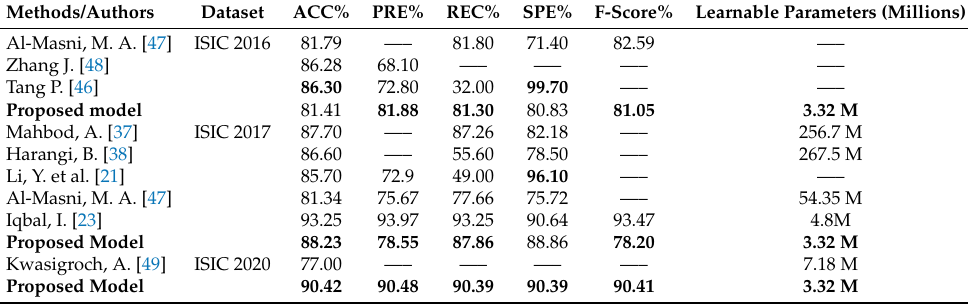
Table 7. Performance comparison of LCNet with other state-of-the-art